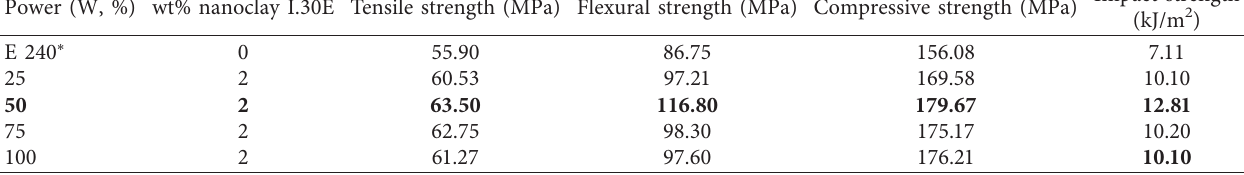
Table 9: Mechanical properties of epoxy Epikote 240/nanoclay I.30E nanocomposite materials with different ultrasonic stirring power.